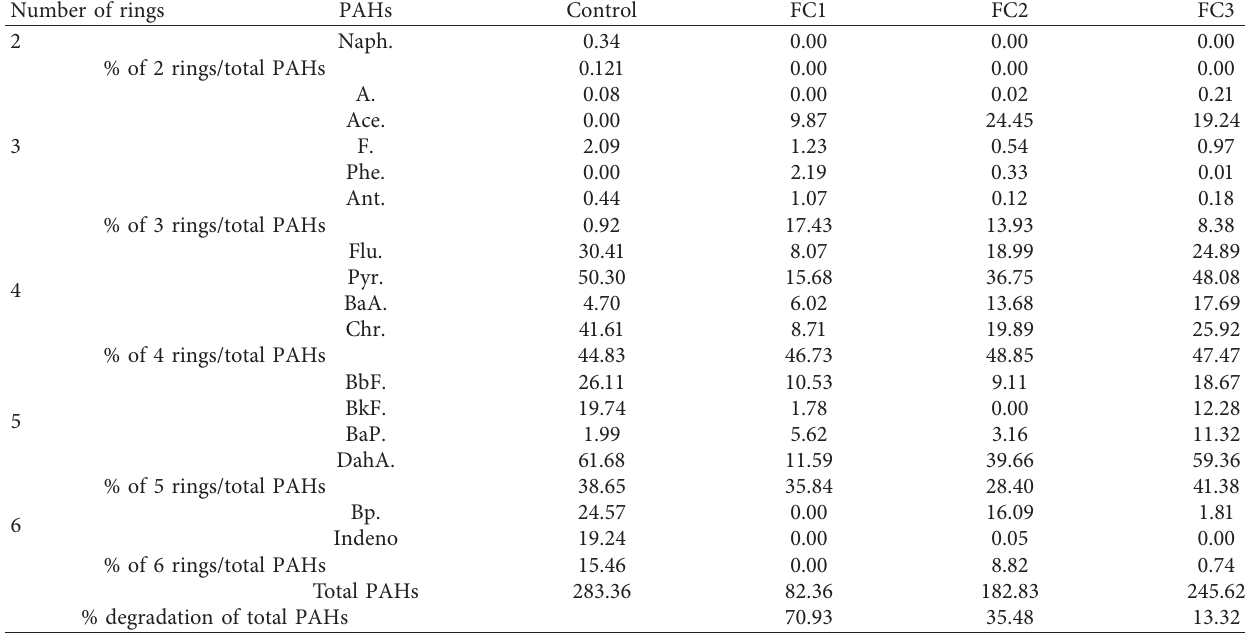
Table 4: Changes in the mixture of PAHs (mg/l), estimated by HPLC, for samples treated with three fungal consortia corresponding to untreated control. FC1 = mixed culture of Penicillium chrysogenum and Curvularia brachyspora , FC2 = mixed culture of Scopulariopsis brevicaulis and Stemphylium botryosum , and FC3 = mixed culture of Scopulariopsis brevicaulis , Stemphylium botryosum, and Cladosporium sphaerospermum . Nap � naphthalene, A � acenaphthylene, Ace � acenaphthene, F � fluorene, Phe � phenanthrene, Ant �